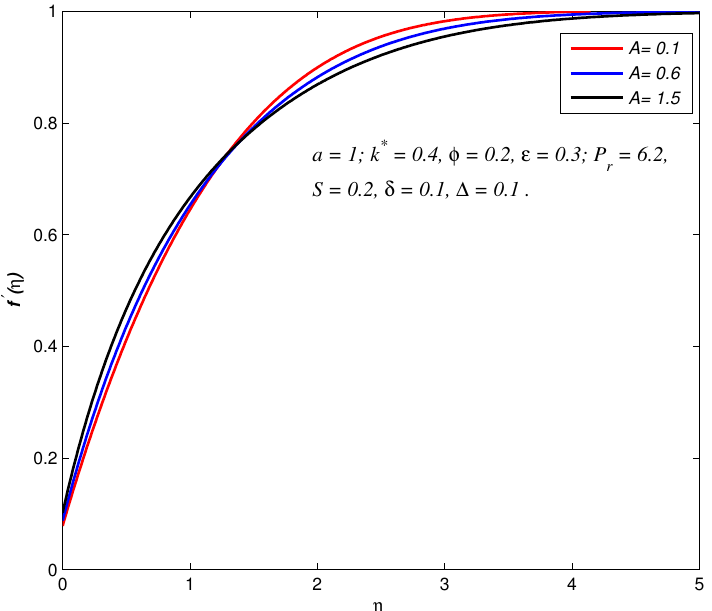
Figure 7. Velocity f (cid:48) ( η ) profiles for different values of viscosity parameter A .